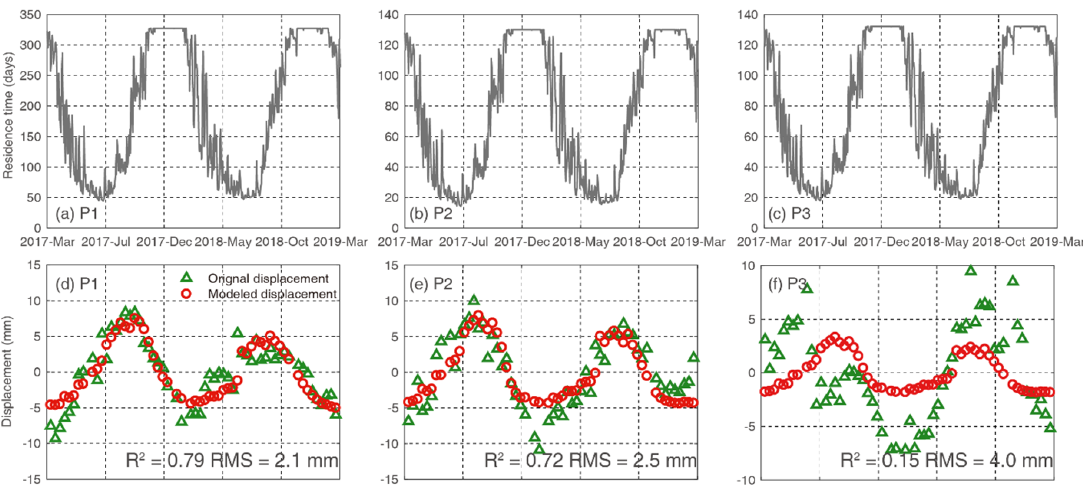
Figure 10. ( a )–( c ) The residence times of rainwater at P1, P2, and P3; ( d )–( f ) InSAR-measured versus modeled nonlinear displacements at points P1, P2, and P3.